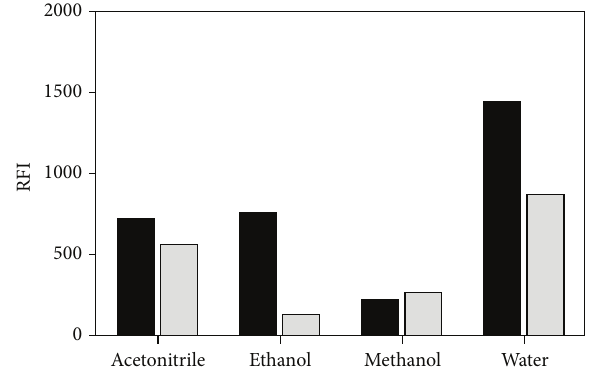
Figure 6: Effect of the diluting solvent on RFI of MRZ (100ng/mL) (gray column MRZ alone and black column MRZ-SLS).